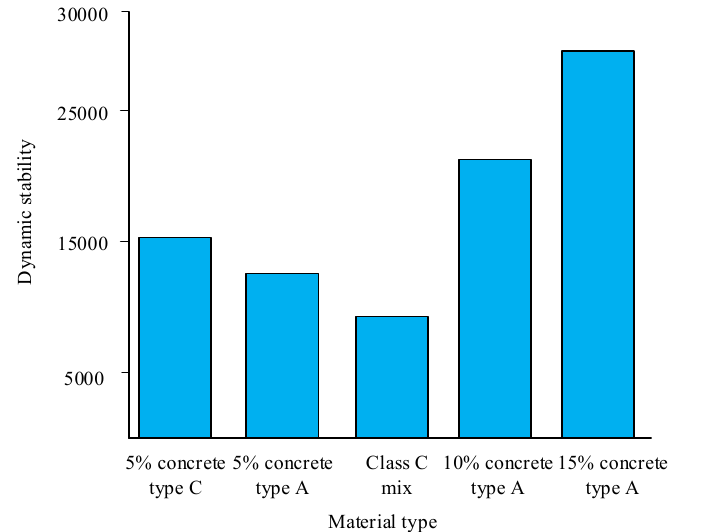
Figure 6. Dynamic stability of concrete with different ER.